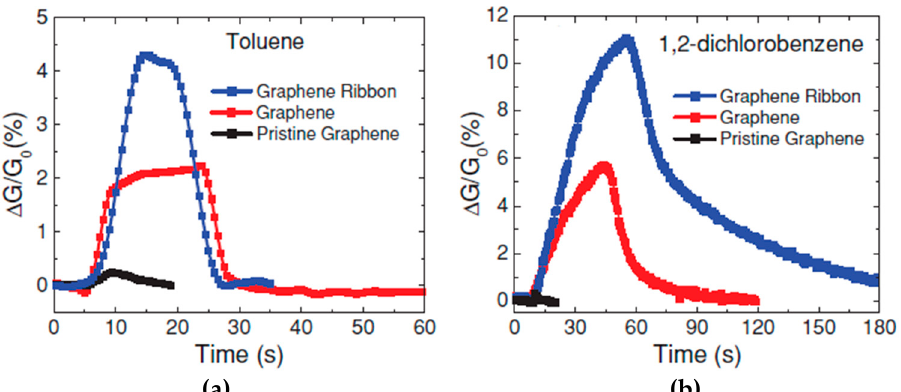
Figure 10. ( a ) Ratio of conductance to initial conductance response of CVD-grown defective graphene, CVD graphene microribbon, and 5 μ m wide pristine (exfoliated) graphene sensors to 10 14 molecules of toluene; and ( b ) CVD-defective graphene, CVD graphene microstrip and a 5 μ m conductivity change of 10 15 1,2-Dichlorobenzene molecules [69].